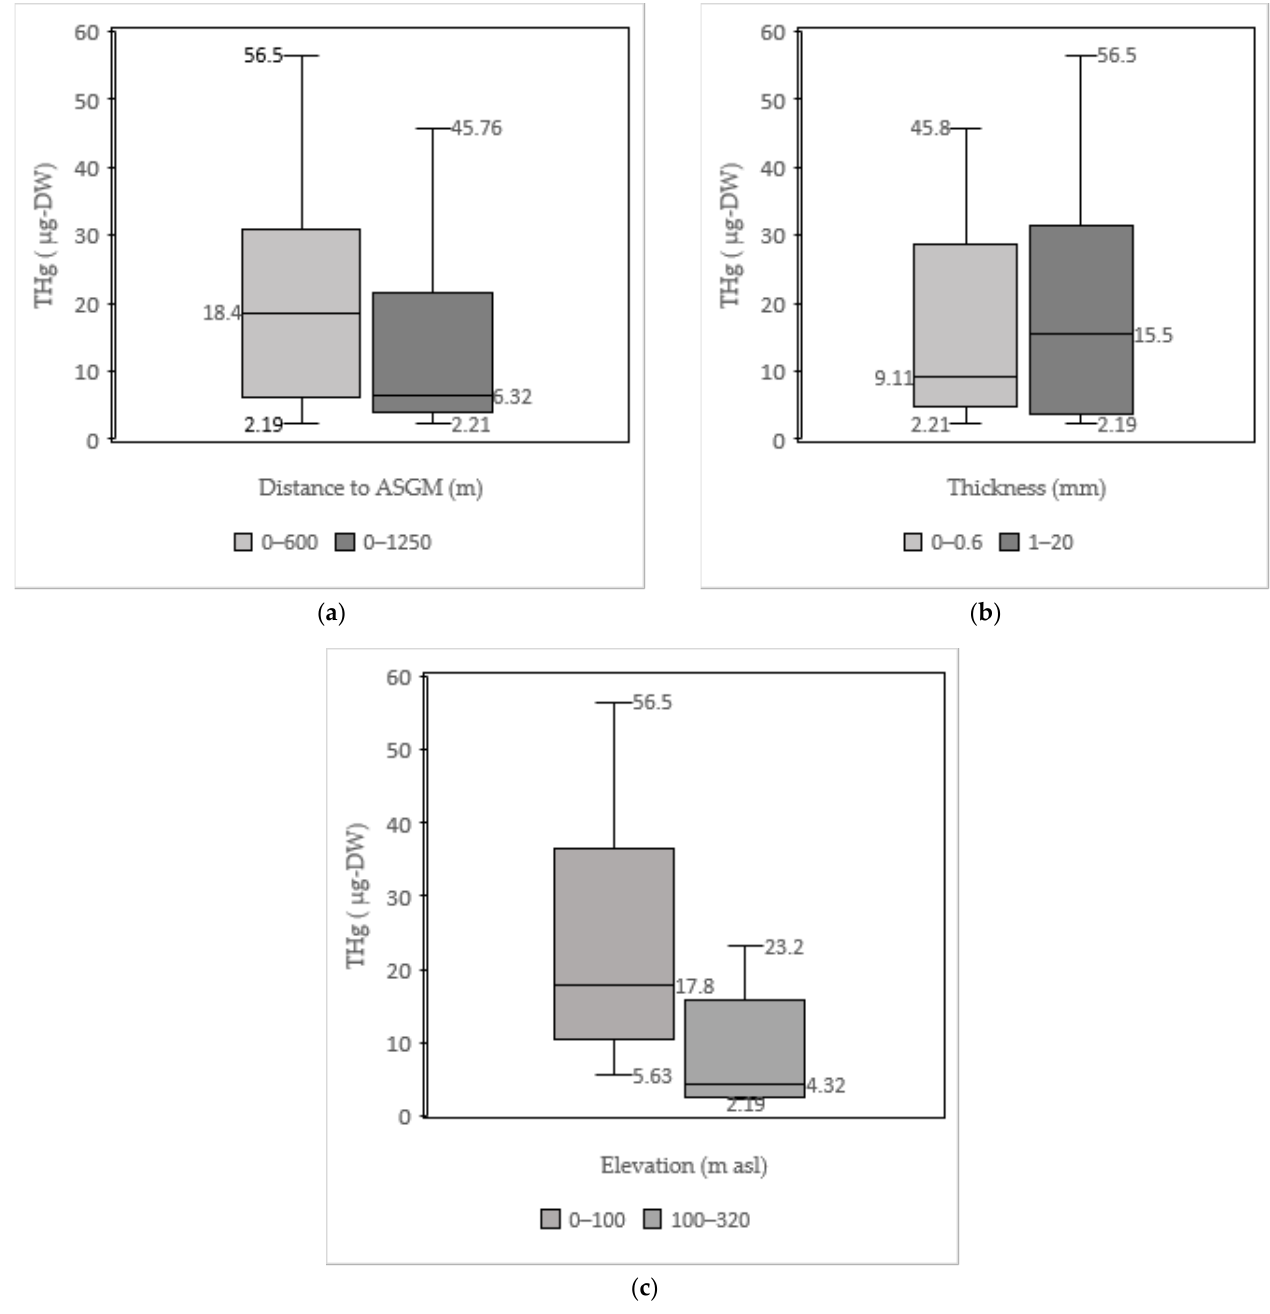
Figure 6. ( a ) Distance, ( b ) thickness, and ( c ) elevation. = 2q box, = 3q box.